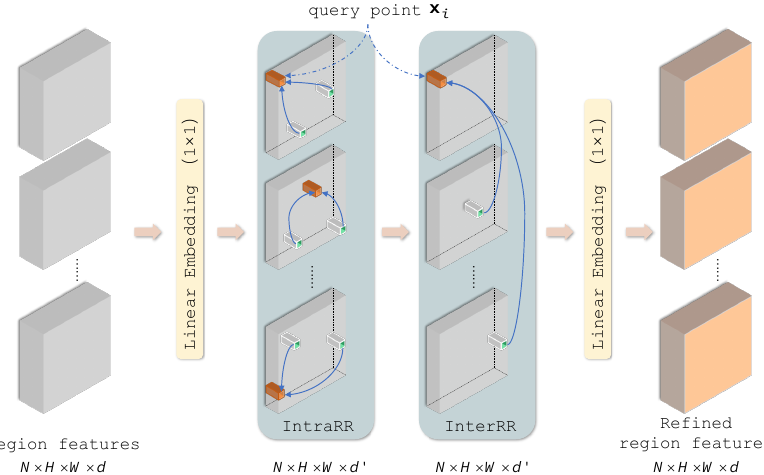
Figure 3. The proposed RCN receives the input from the features of multiple detected regions while enforcing the same dimension for the input and output. RCN consists of two main parts, Intra-Region Relation (IntraRR) and Inter-Region Relation (InterRR).